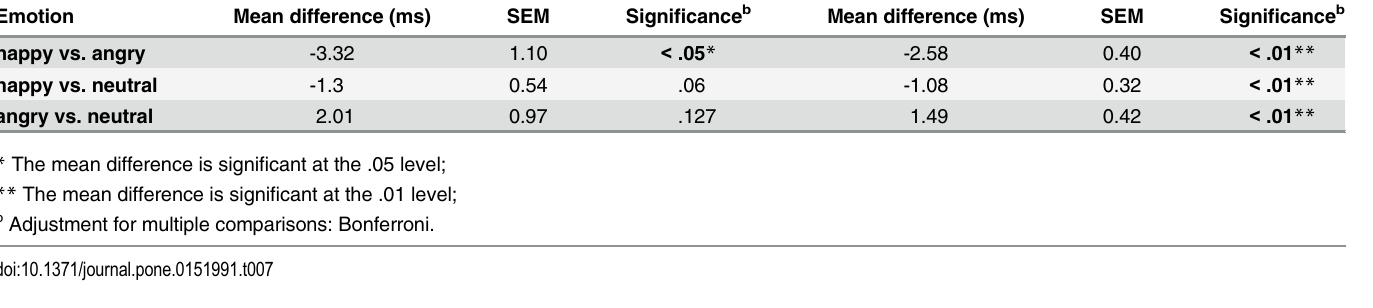
happy vs. angry < .01 ** happy vs. neutral < .01 ** angry vs. neutral < .01